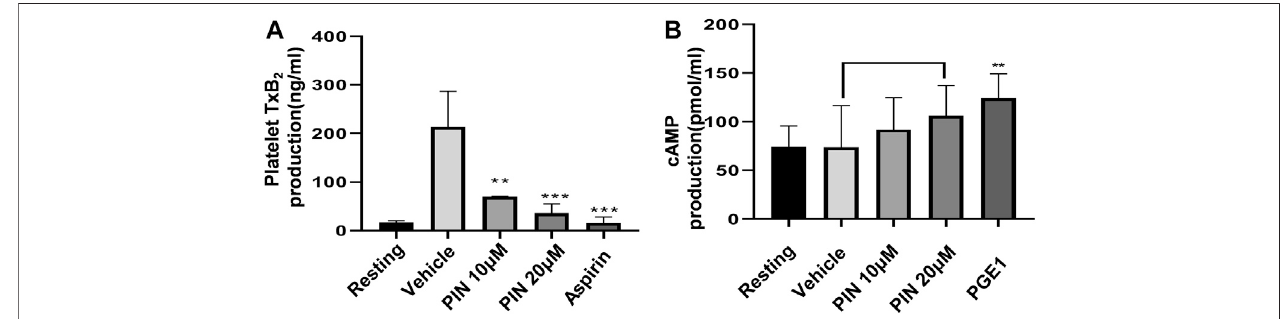
FIGURE 4 | Effects of pimpinellin on cAMP levels, and TxB 2 production. (A) We pre-incubated washed human platelets (3 × 10 8 /ml) with vehicle, different concentrations of pimpinellin, or aspirin (100 μ M) for 10 min, after which the platelets were stimulated with collagen (1 μ g/ml). TxB 2 production levels were evaluated by measuring the OD values. Results were expressed as TxB 2 production (ng/ml). (B) Washed human platelets (3 × 10 8 /ml) were pre-incubated with the vehicle, different concentrations of pimpinellin or PGE1 (50 ng/ml) for 10 min, after which they were stimulated with collagen. After 5 min, the supernatant was obtained by centrifugation. The effect of pimpinellin on cAMP levels was determined by detecting OD value. Data are mean ± SEM values ( n (cid:2) 4). * p < 0.05, ** p < 0.01, *** p < 0.001 compared to the vehicle